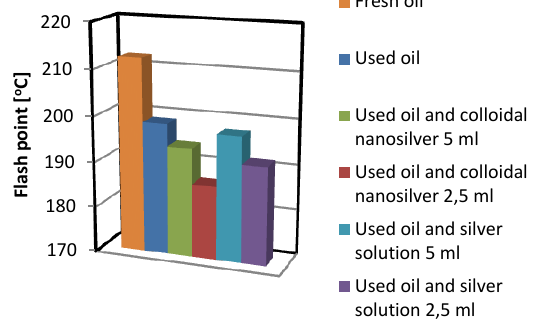
Fig. 13. Flash point oil of used oil and used oil with colloidal nanosilver and